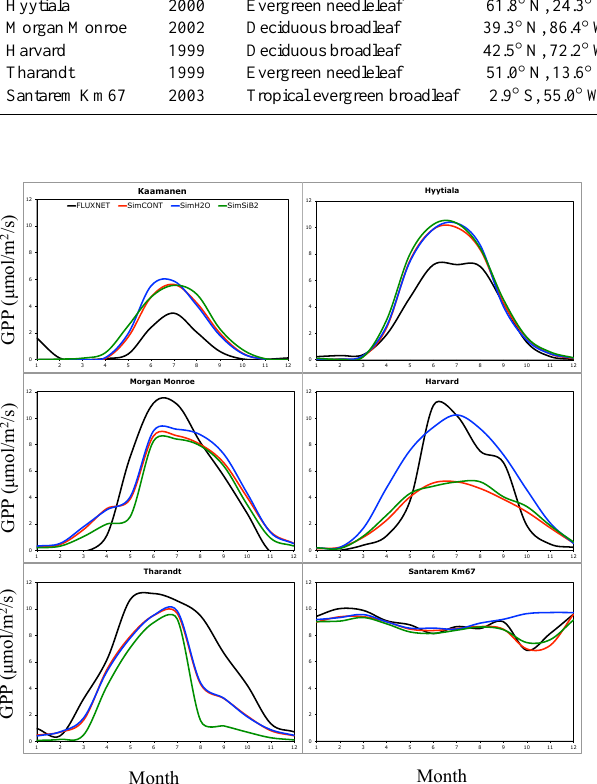
Fig. 5a. Comparison of eddy-derived and modeled monthly average Figure 5(a). Comparison of eddy-derived and modeled monthly average GPP fluxes at 6 GPP fluxes at 6 FLUXNET sites (µmolCm − 2 s − 1 ). FLUXNET sites ( µ mol/m 2 /s).